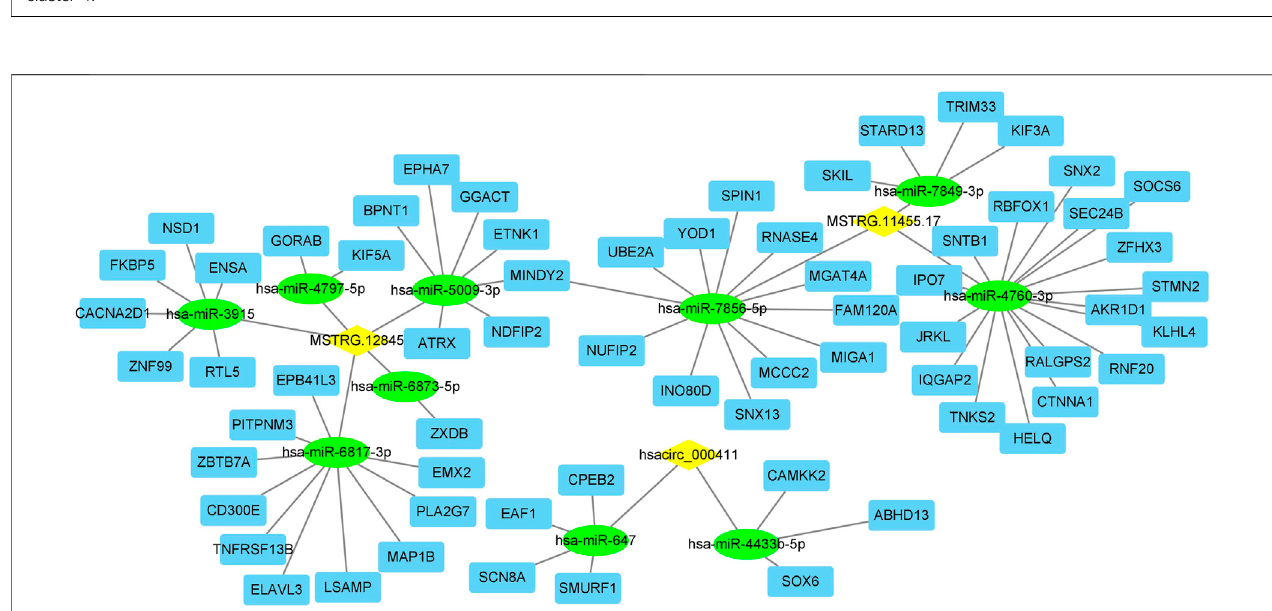
FIGURE 3 | The lncRNA (or circRNA)-miRNA-mRNA interactions network. Yellow diamond: lncRNA or circRNA; green circle: miRNA; blue square: mRNA.